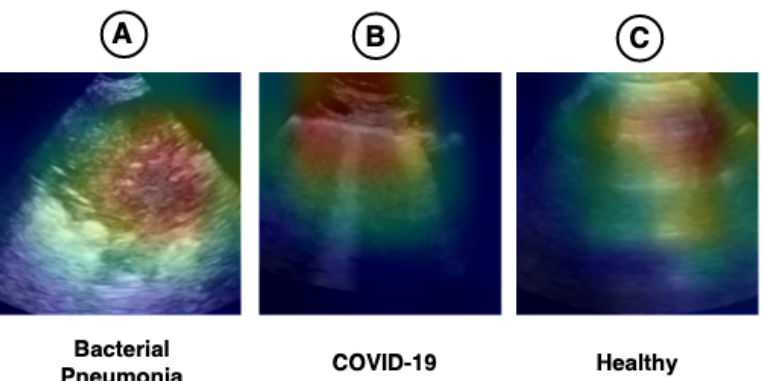
Figure 8. Heat maps referring to the regions considered the most important for the model (Xception) according to the Grad-CAM technique. Image ( A ) shows a large consolidation area related to the diagnoses of bacterial pneumonia. Image ( B ) shows B-lines (vertical lines) and an irregular pleura line, both related to US diagnosis of COVID-19. Image ( C ) is a lung with a healthy diagnosis, where there are the named A-lines (horizontal lines) and a regular pleural